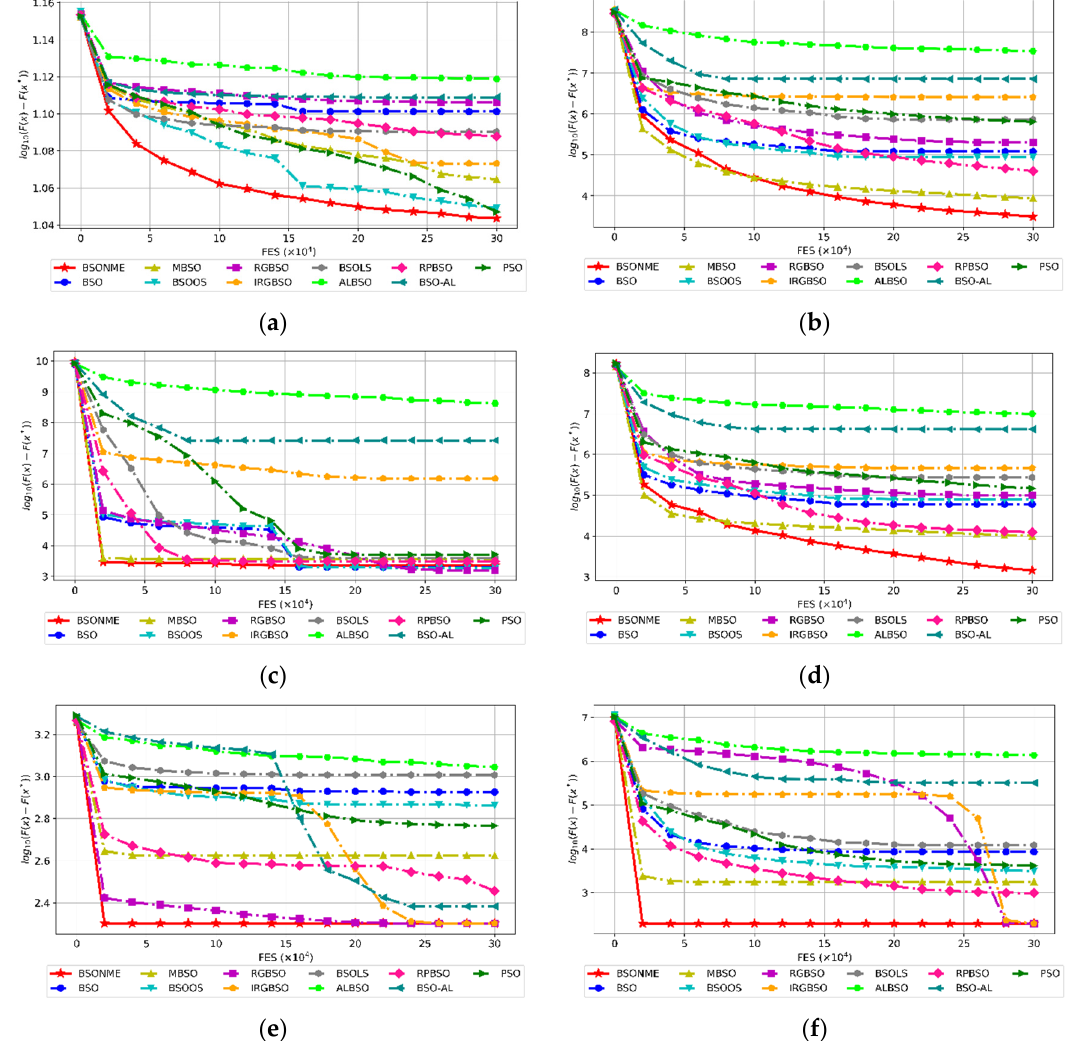
Figure 9. Evolution of the mean values of solution error derived from PSO, BSO, MBSO, BSO-OS, RGBSO, IRGBSO, BSOLS, ALBSO, RPBSO, BSO-AL, and BSONME versus the number of FES on six test problems. ( a ) F 16 ; ( b ) F 17 ; ( c ) F 18 ; ( d ) F 21 ; ( e ) F 27 ; ( f ) F 30 .